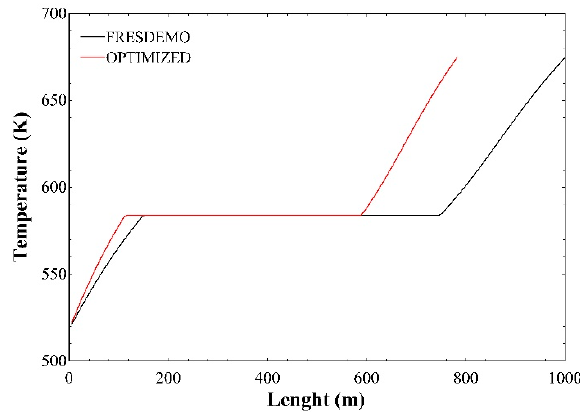
Figure 16. Water/steam temperature along the Fresnel loop in once ‐ through operation mode. Figure 16. Water / steam temperature along the Fresnel loop in once-through operation